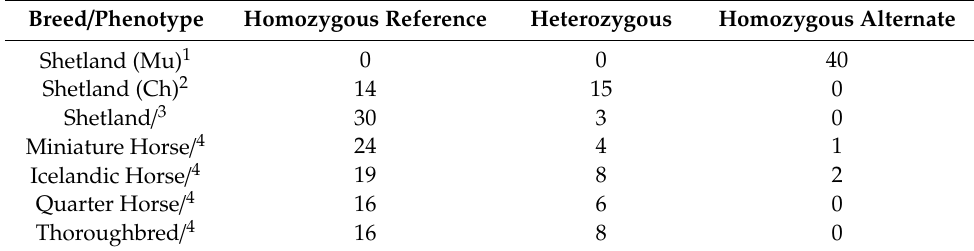
Table 2. ECA7 326 kb mushroom associated haplotype data across breeds. The mushroom associated haplotype was genotyped in the Shetland Pony and four additional breeds.